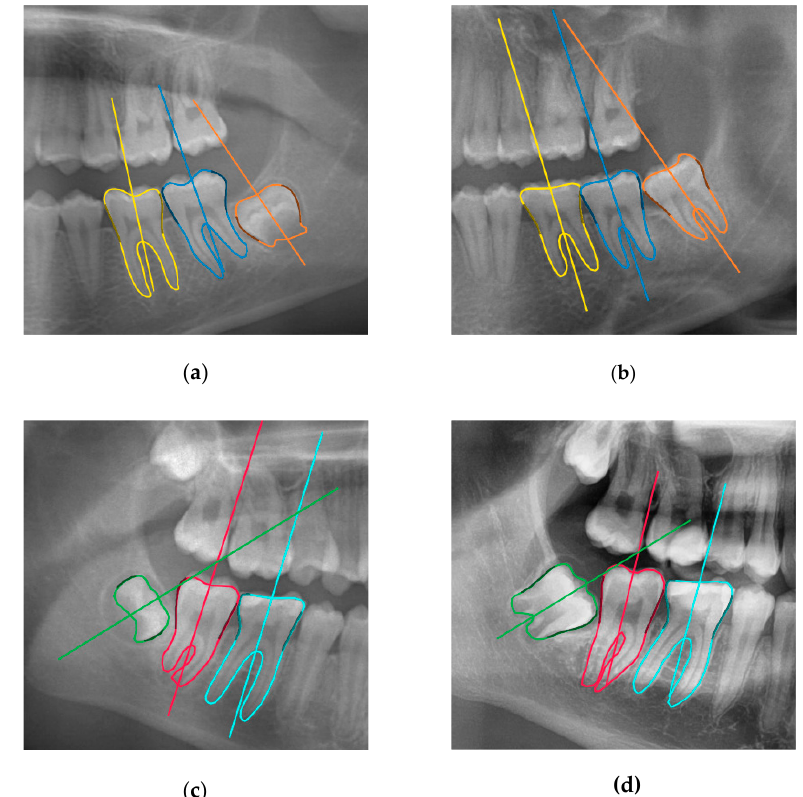
Figure 4. Consecutive panoramic radiographs with a 4-year interval showing third molar eruption in ( a , b ); and third molar impaction in ( c , d